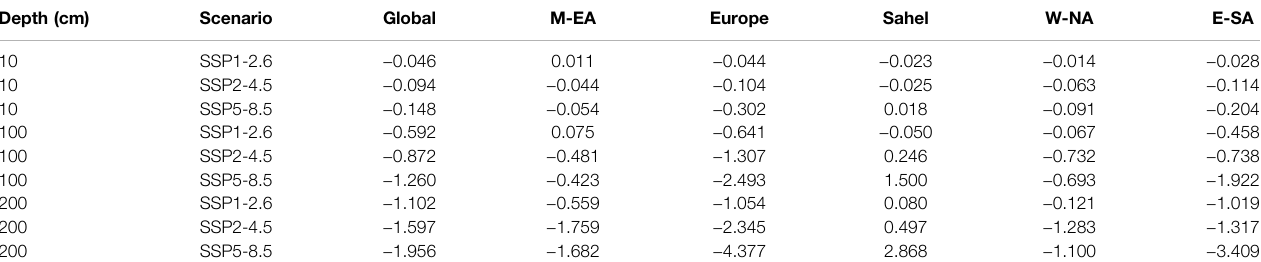
TABLE 4 | Soil moisture trend (kg/m2/decade, 2015 – 2100) of global average and selected hotspots under different emission scenarios in the future. The M-EA is mid- latitudes of East Asia, the W-NA is Western North America, and the E-SA is Eastern South America.